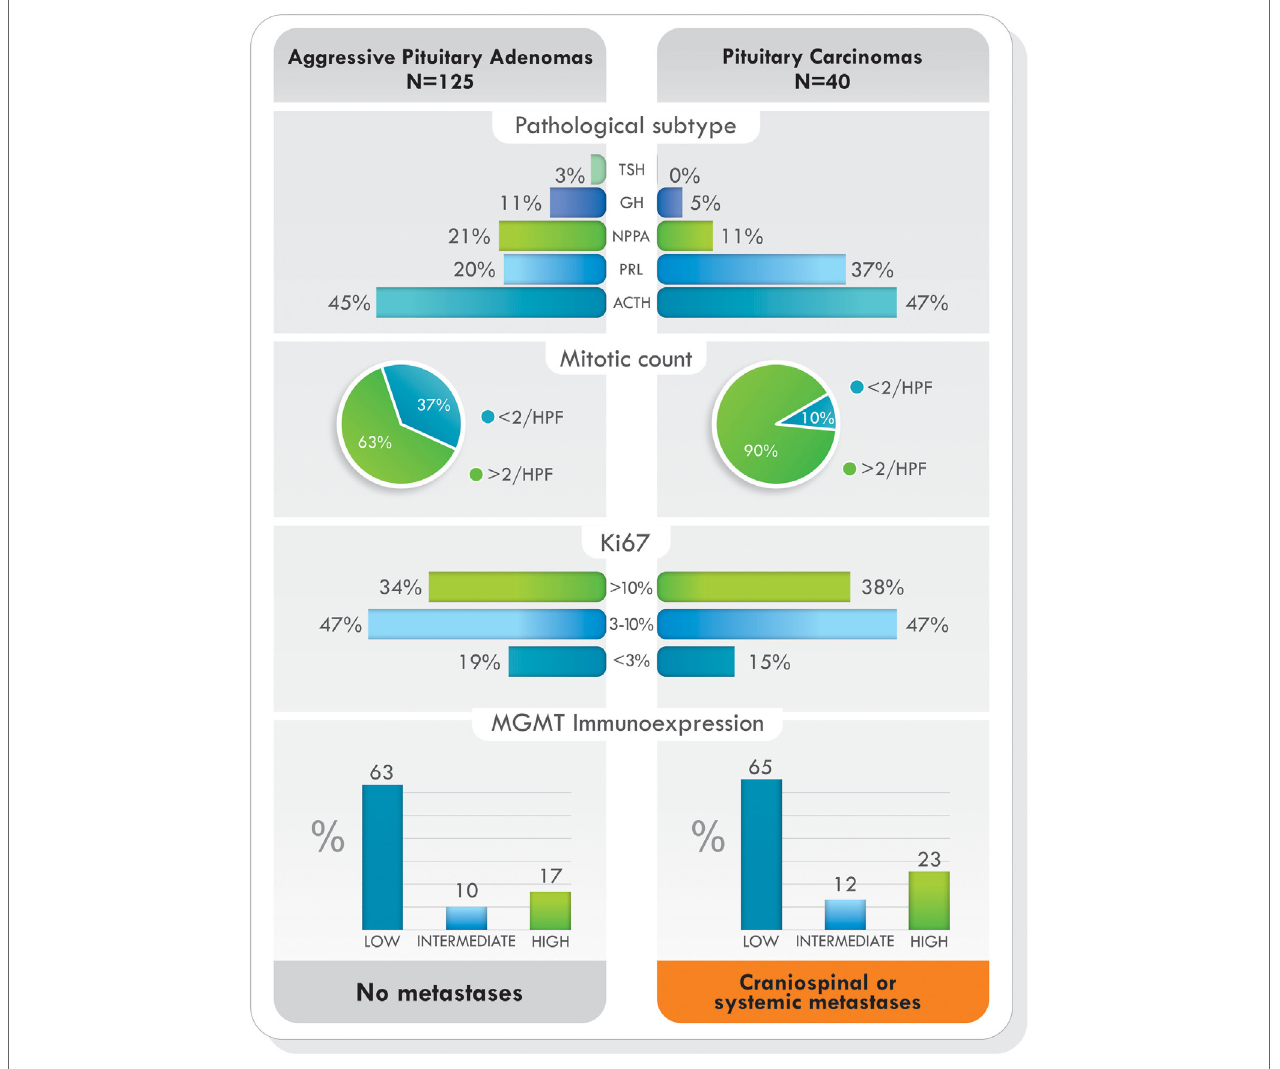
FiGURe 5 | Pathological subtype of tumors, proliferative markers, and O6-methylguanine-DNA methyltransferase (MGMT) immunoexpression in aggressive pituitary adenomas and pituitary carcinomas treated with temozolomide. Data from Ref. (77). Abbreviations: TSH, thyroid-stimulating hormone; GH, growth hormone; NPPA, non-functioning pituitary adenoma; PRL, prolactin; ACTH, adrenocorticotropic hormone; HPF, high-power field; MGMT, O6-methylguanine-DNA